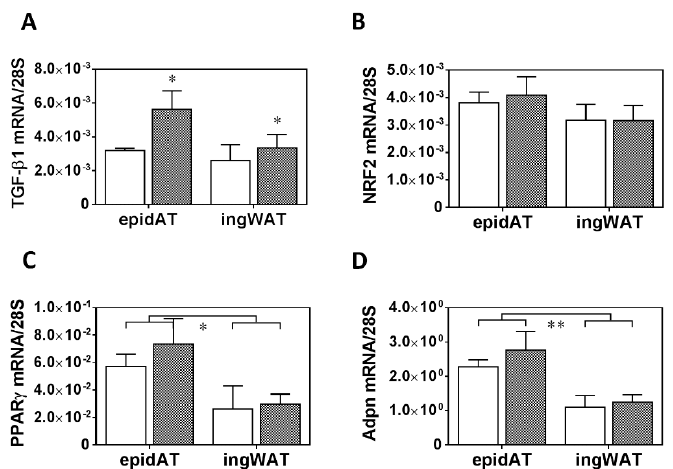
Figure 3. Gene-expression of adipose tissue remodelling indicators. ( A ) TGF- β 1 , ( B ) Nrf2 , ( C ) PPAR γ , and ( D ) adiponectin ( Adpn ) mRNA expression in epididymal (epidAT) and inguinal white (ingWAT) adipose tissues in obese prediabetic (PRED, grey columns) and control (CON, white columns) rats at the end of the study. Data are means ± SEM, n ≥ 8 / group. Two-way RM ANOVA; *: p < 0.05, **: p < 0.01; ***: p < 0.0001.